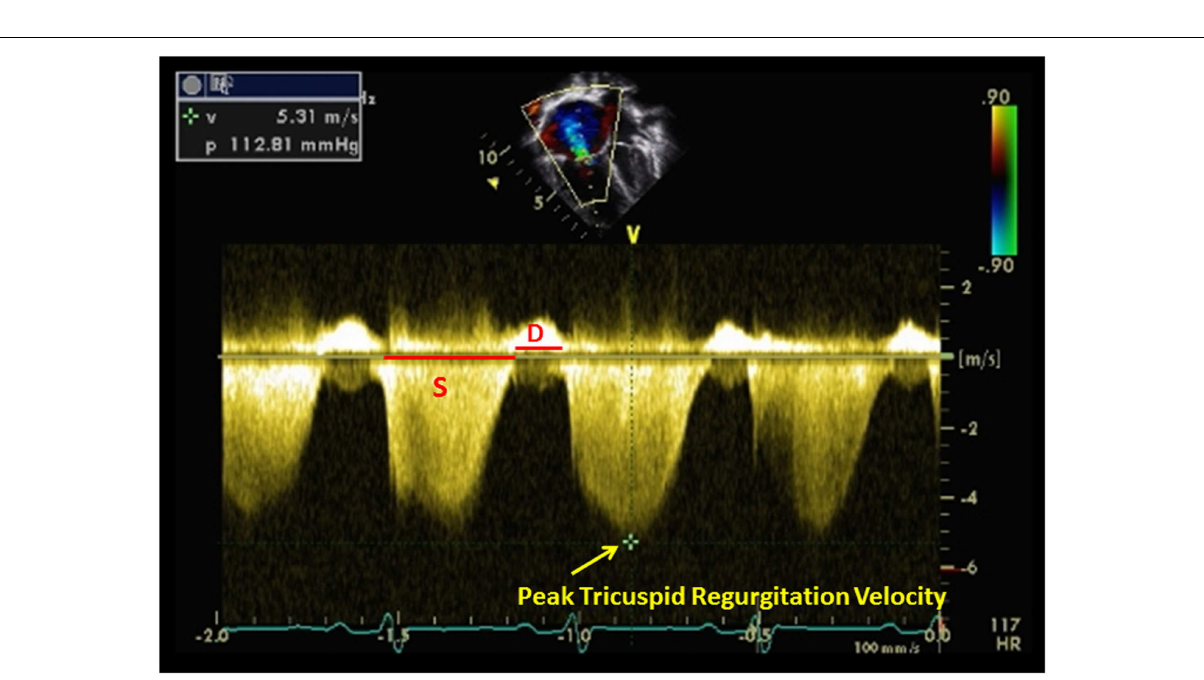
FIGURE 5 |Tricuspid regurgitation estimating right ventricular pressure in a patient with pulmonary hypertension . Systolic ( S ) to diastolic ( D ) ratio from tricuspid regurgitation velocity can be measured.